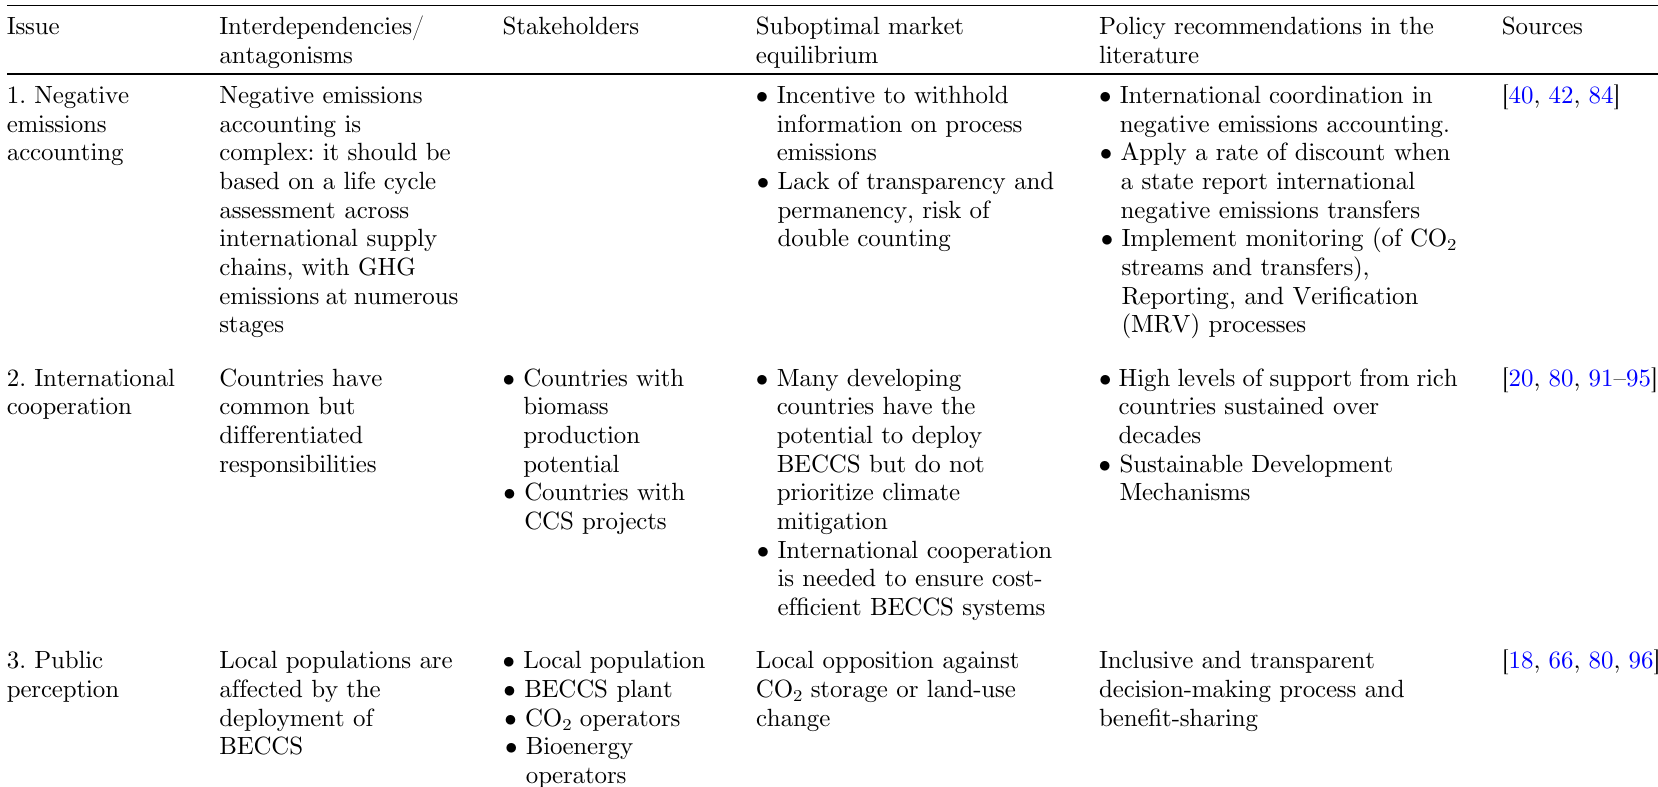
Table 4. Overall